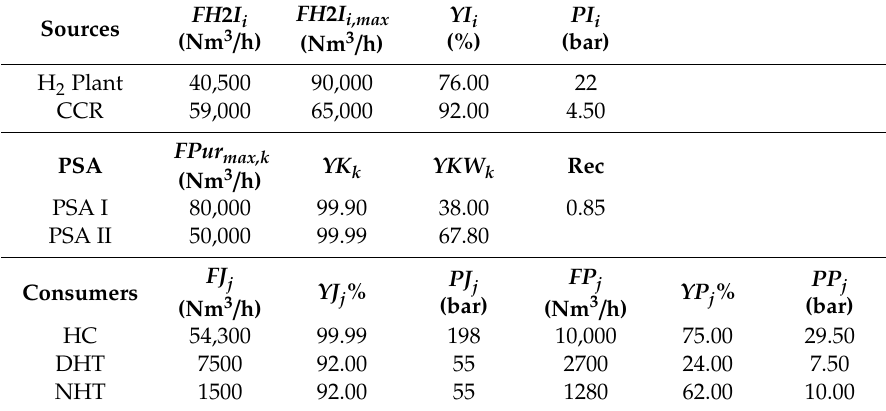
Figure 7. Existing hydrogen network for Example 2. Table 5. Flowrate, purity and pressure information used in Example 2.